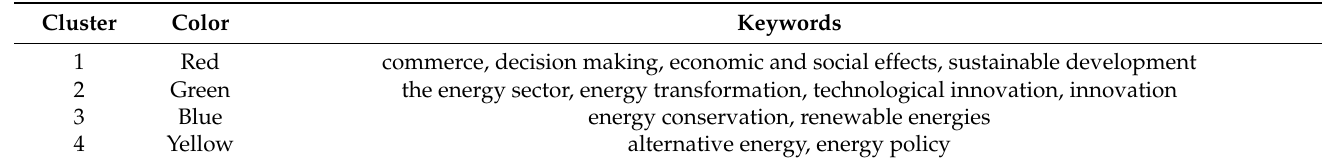
Figure 5. Bibliometric map of indexed keyword co-occurrence results from Scopus based on Query 18. Counting method: full counting. Minimum keyword co-occurrence is 10. Source: authors’ elaboration performed in VOSviewer (version 1.6.18). Table 5. Clusters of index keyword co-occurrences in Figure 5 for Scopus.